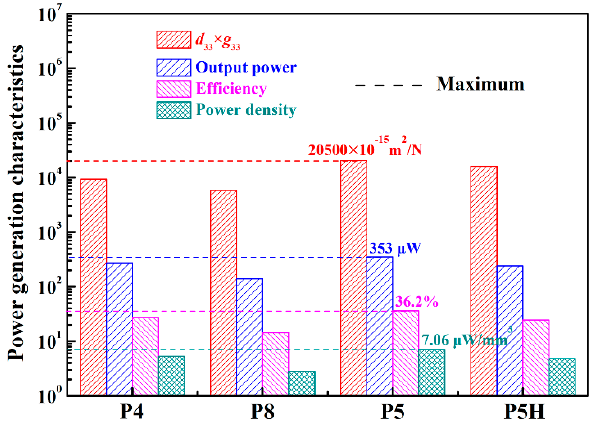
Figure 7. Comparison for the power generation characteristics of the hard and soft PZT ceramics.